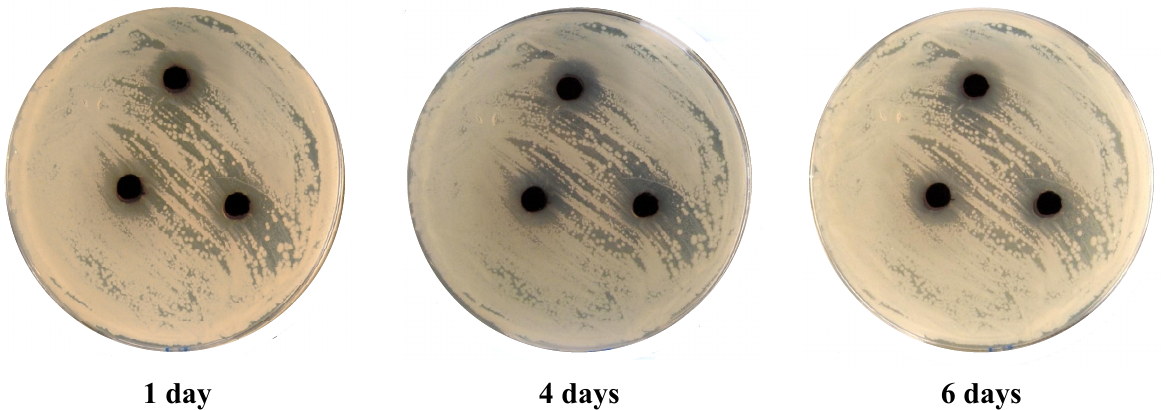
Figure 3. E. coli . treated with 100 mg/mL of dye 3 after 1, 4, and 6 days of